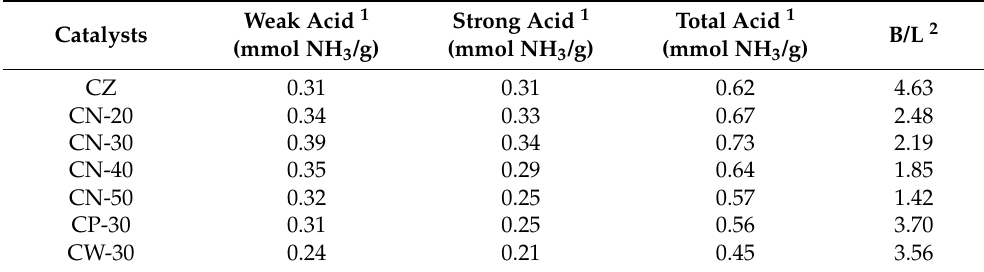
Table 1. The NH 3 -TPD and Py-FTIR quantitative results of the catalysts. Catalysts